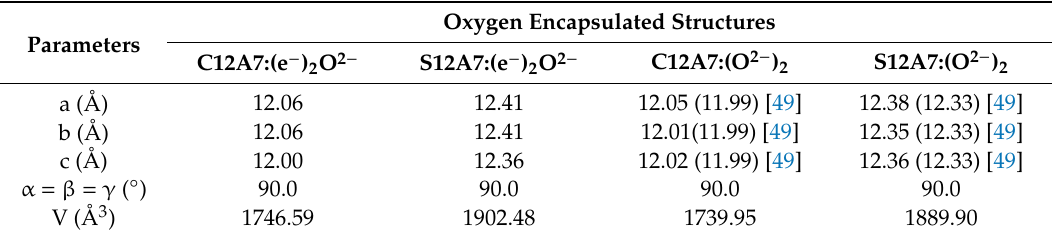
Table 2. Calculated lattice parameters of oxygen encapsulated structures. Available experimental values are provided in parentheses.